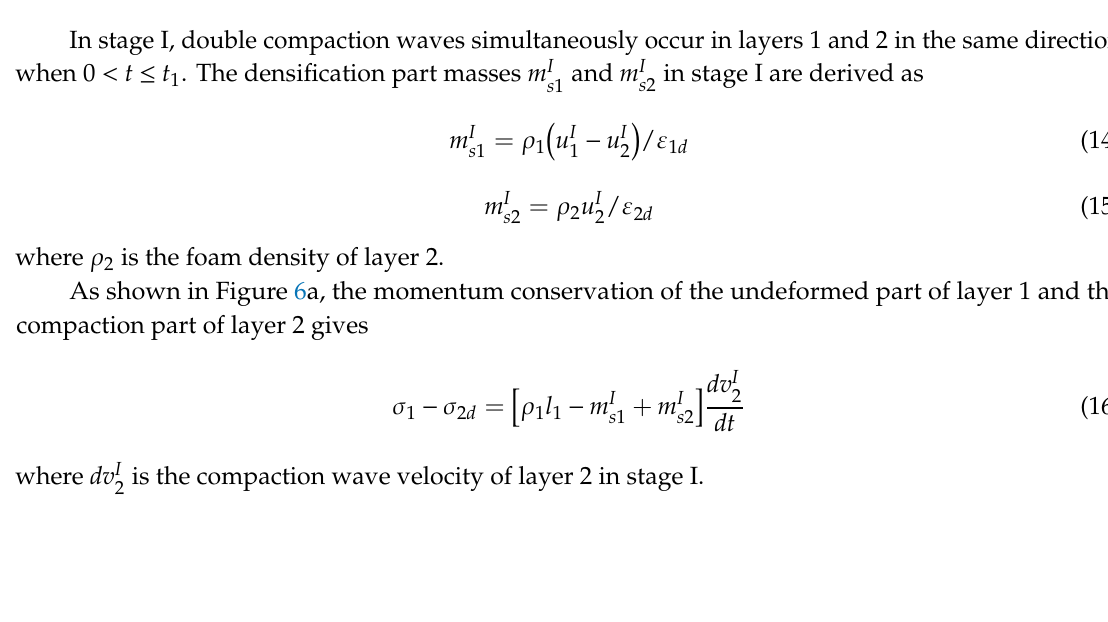
Figure 5. Response process of the core with a negative gradient.